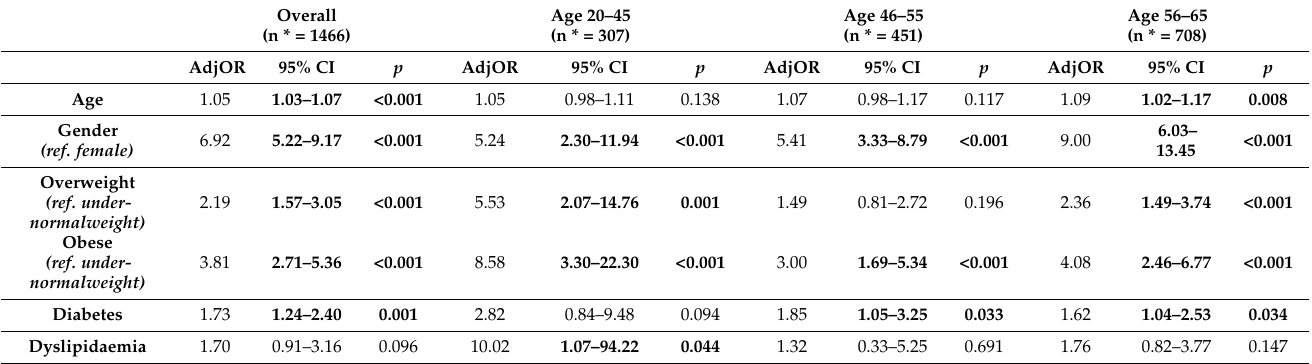
Table 3. Multivariable analysis evaluating variables independently associated with mortality in the overall study population and in the 3 age